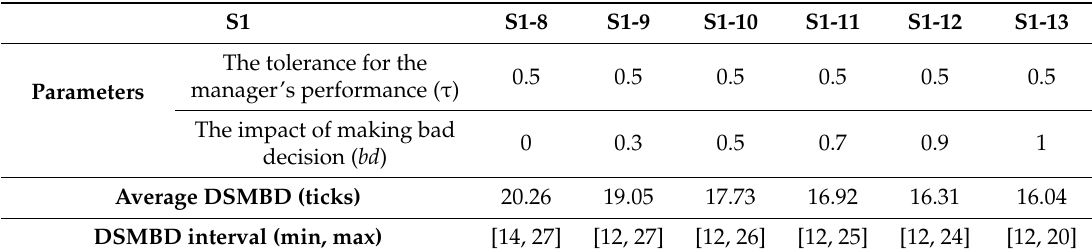
Table 7. Simulation’s results for S1 when τ = 0.5.